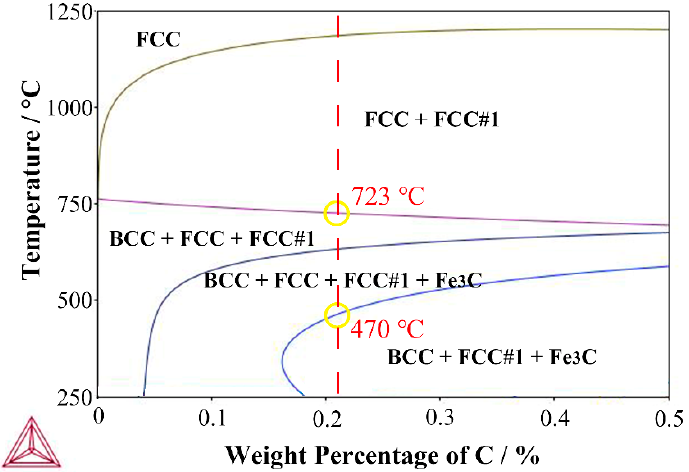
Figure 1. Phase diagram of the 0.2C-5Mn steel.